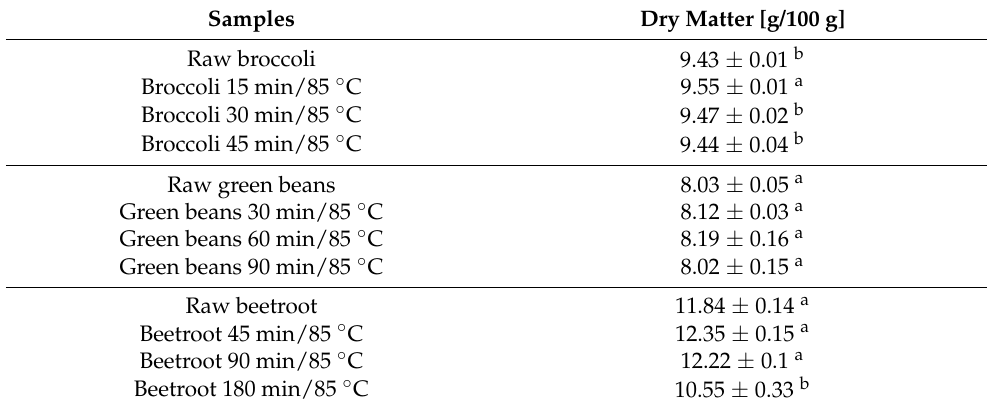
Table 2. Dry matter content in the tested samples of raw and conducted to sous-vide treatment